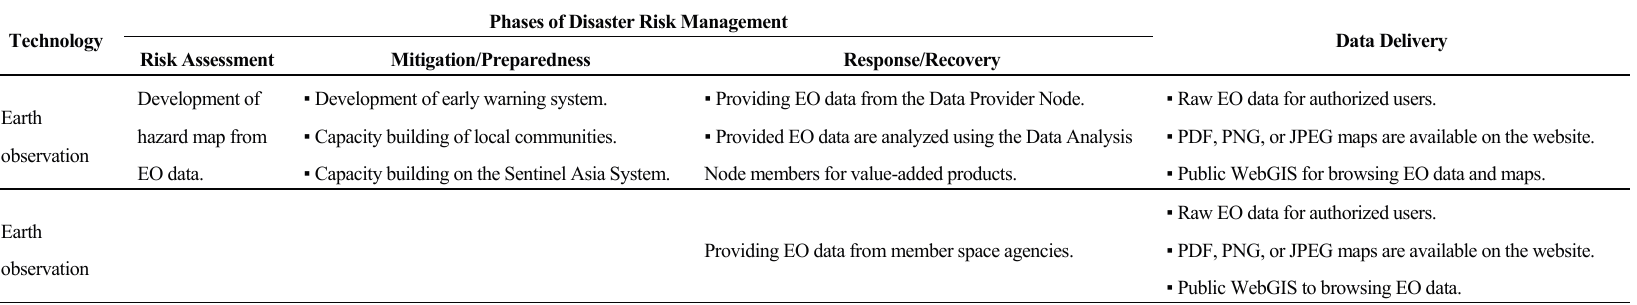
Table 1. Activities of Geospatial Data Delivery for Disaster Risk